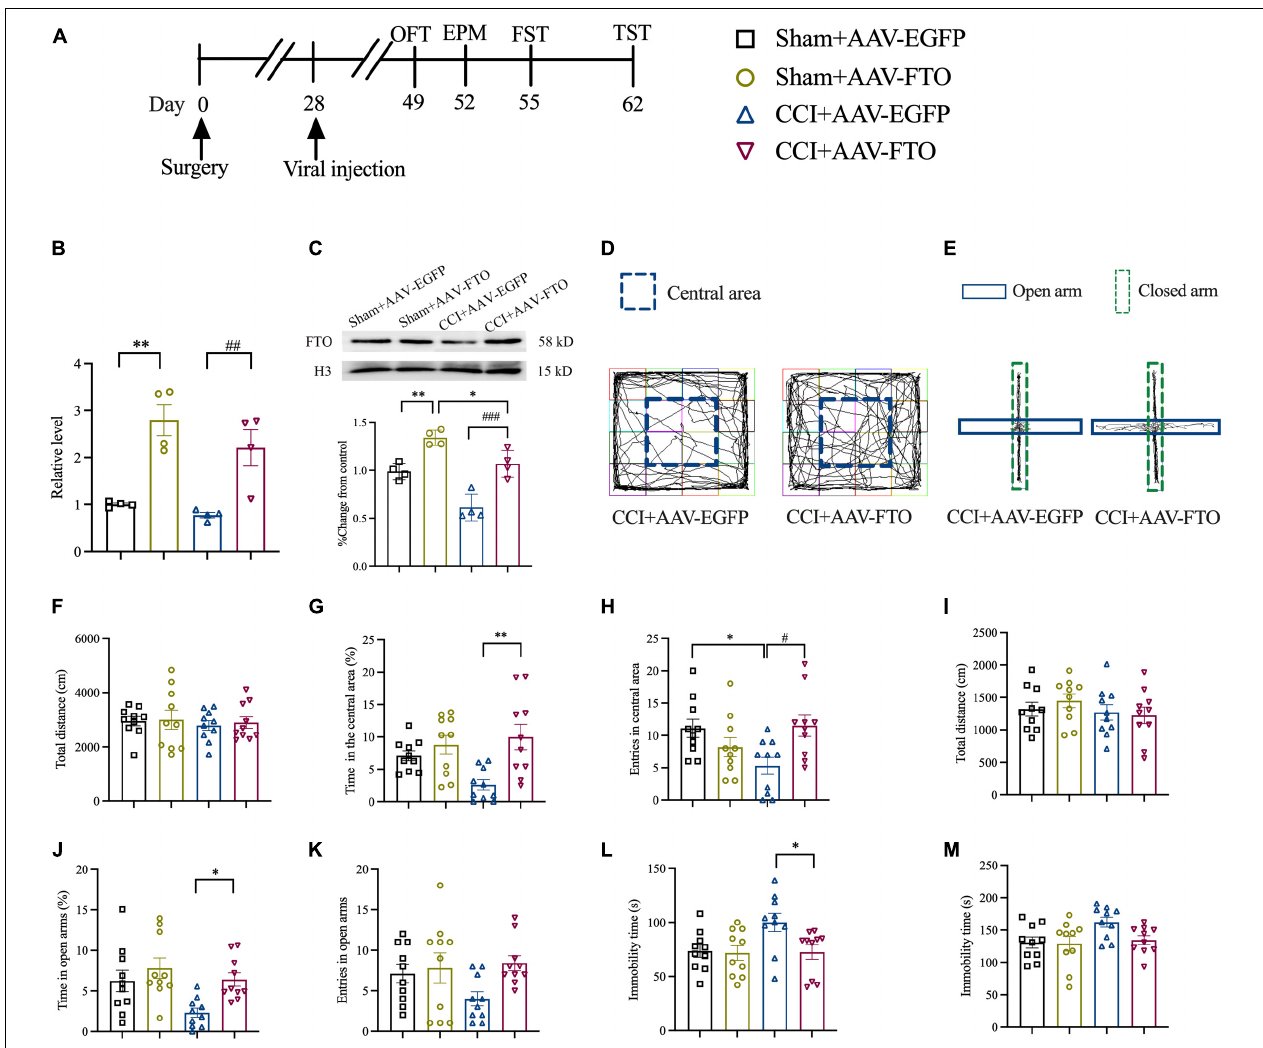
FIGURE 3 | Overexpression of FTO in ACC reversed anxiety- and depression-like behaviors in CCI mice. (A) The schematic diagram of the experimental arrangement. (B,C) qRT-PCR and Western blot results showed that the expression levels of FTO mRNA and protein in mice ACC 21 days after AAV injection ( ∗ P < 0.05, ∗∗ P < 0.01 vs. Sham-AAV-EGFP; ## P < 0.01, ### P < 0.001 vs. CCI-AAV-EGFP, n = 4). (D) OFT trajectory. (E) EPM trajectory. (F) The total movement distance of mice during the OFT. (G) The proportion of residence time in the central area ( ∗∗ P < 0.01 vs. CCI-AAV-EGFP). (H) The number of entries of the central area ( ∗ P < 0.05 vs. Sham-AAV-EGFP; # P < 0.05 vs. CCI-AAV-EGFP). (I) The total movement distance of mice during the EPM. (J) The proportion of exploration time in open arm ( ∗ P < 0.05 vs. CCI-AAV-EGFP). (K) The number of entries of the open arm. (L,M) The immobility time during the FST and TST ( ∗ P < 0.05 vs. CCI-AAV-EGFP). n =